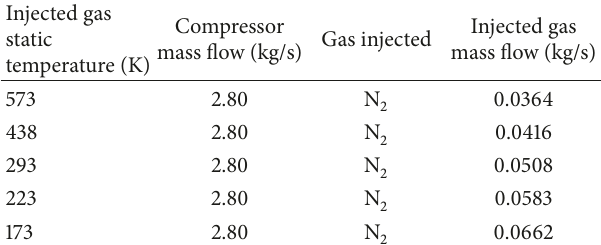
Figure 22: Flow angle in span direction. Table 4: Boundary conditions of different